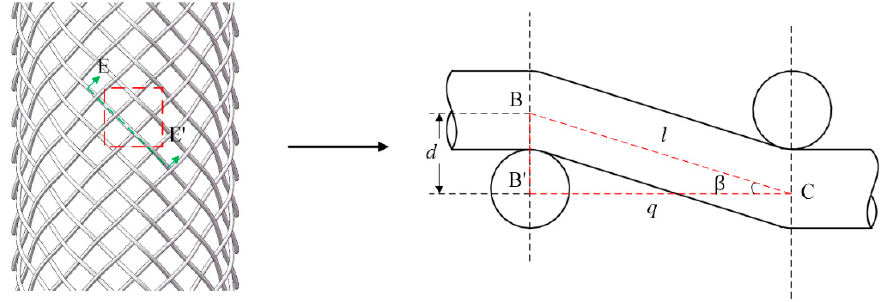
Figure 3. Cross-section of EE’.